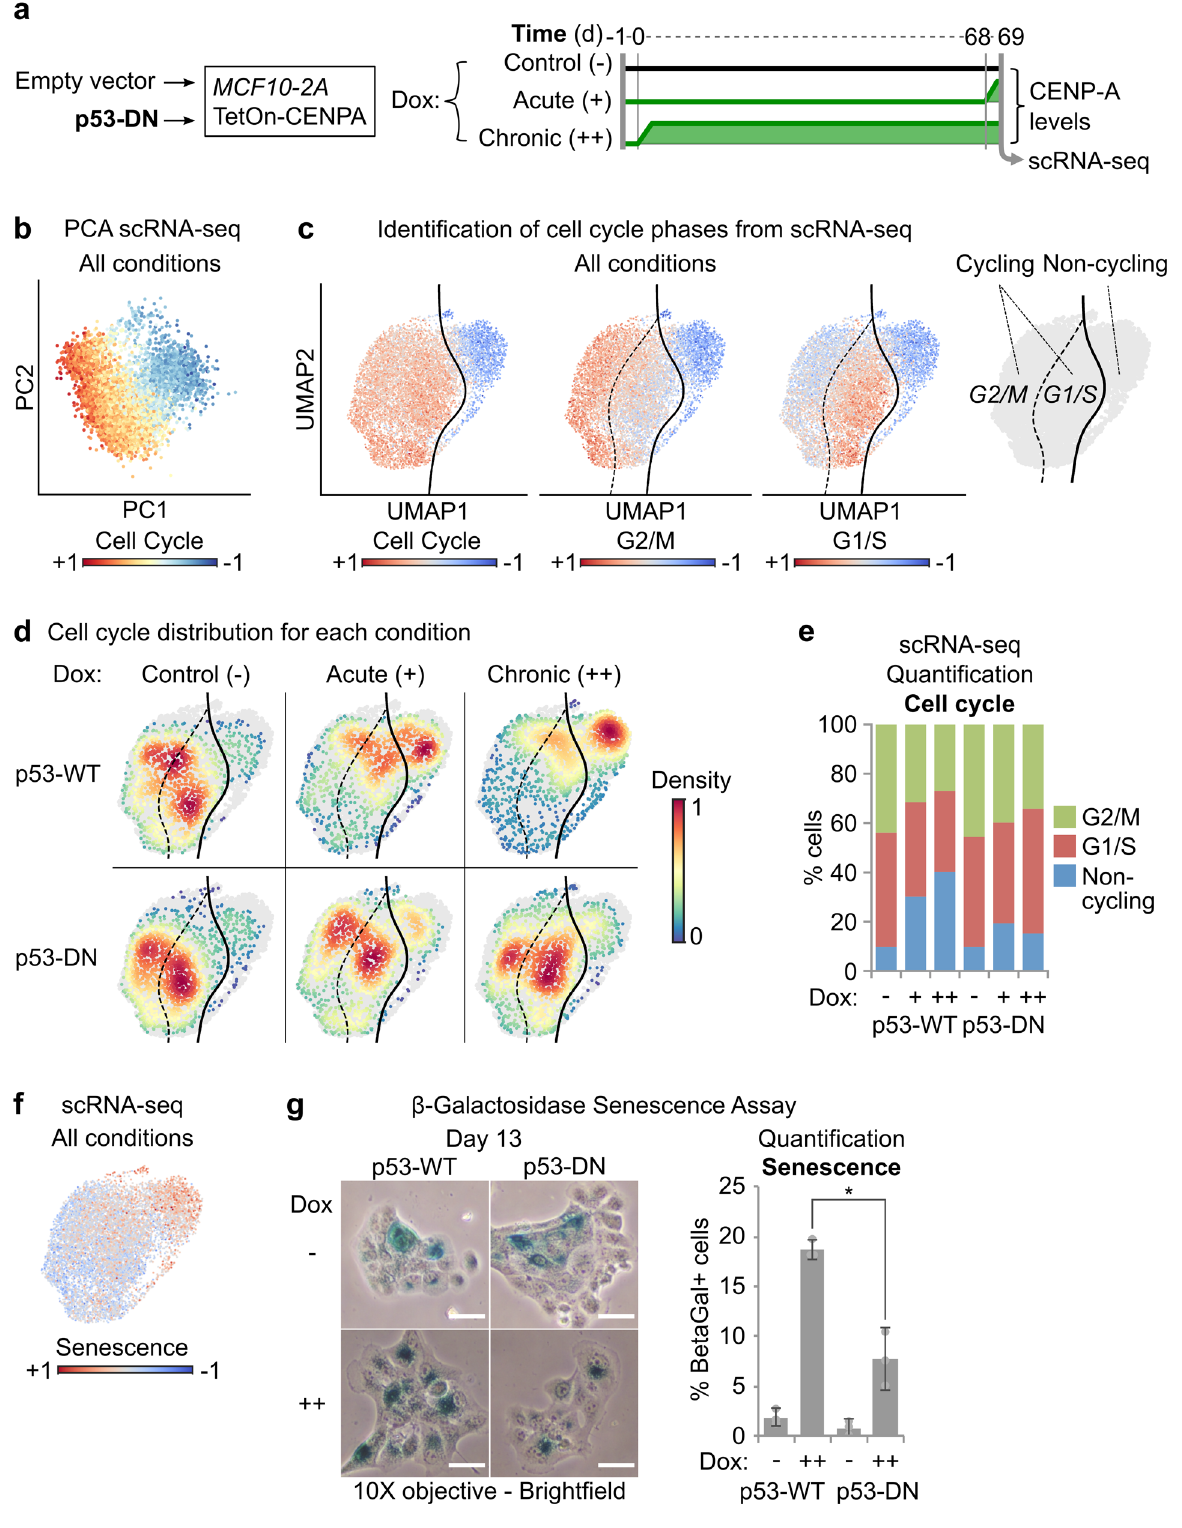
patients or minimize radiotherapy dose for equal therapeutic outcome with reduced side effects. Furthermore, alternative treatment options for patients with nonfunctional p53 could also be considered, as drugs combatting mutant p53 (including LOF mutations) are currently in development 67,68 . A number of these